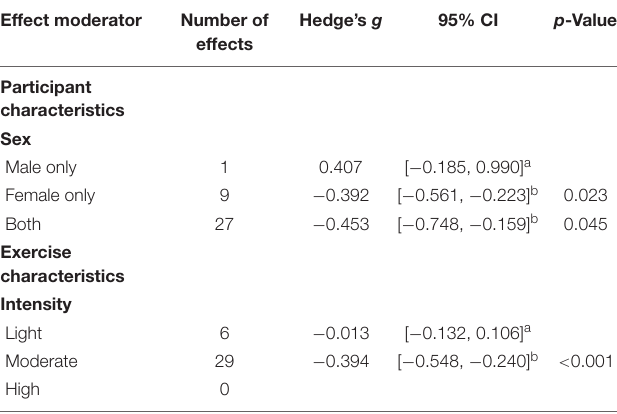
TABLE 2 | Univariate results for significant fatigue categorical moderator